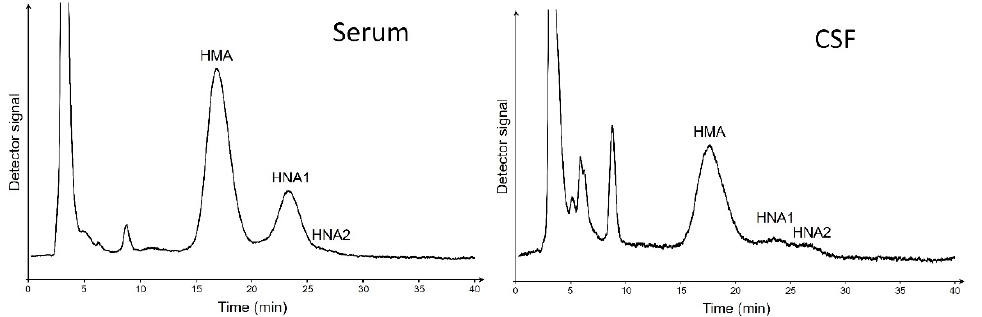
Figure 4. Exemplary HPLC chromatograms of albumin redox fractions in serum and CSF of one MS patient.